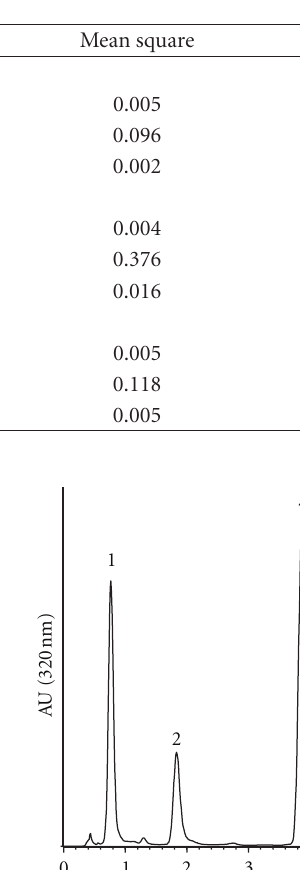
Table 2: ANOVA of caftaric, chlorogenic, and chicoric acid contents estimations of 24 chicory leaves extracted by 4 di ff erent testers using the “novel” method.